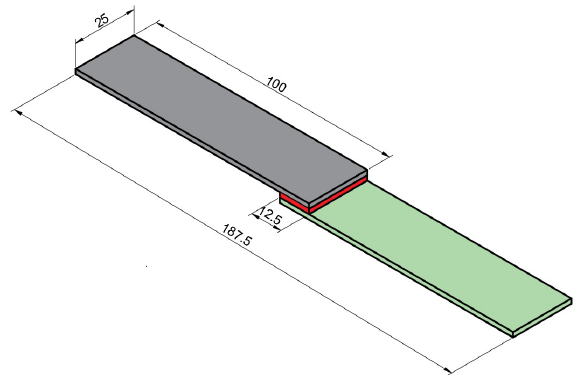
Figure 2. FTIR spectroscopy of organic powders (mussel, walnut, and olive pomace).